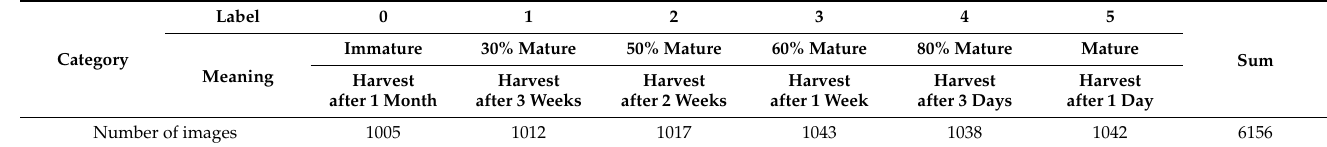
Table 4. Strawberry image classification categories and training data sets.